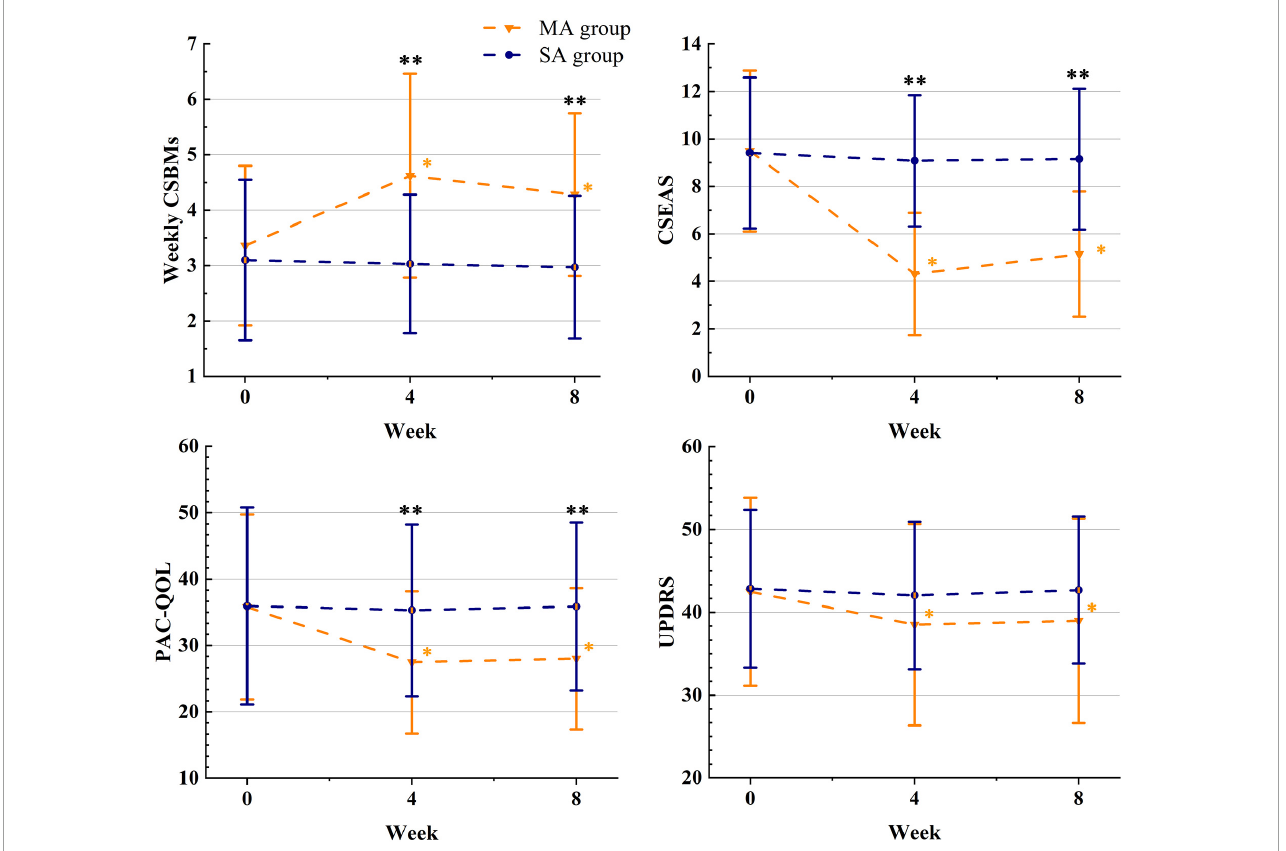
FIGURE2 The therapeutic effects of acupuncture. ∗ The difference with the baseline was significant within group ( P ≤ 0.05); ∗∗ the difference between the groups was significant ( P ≤ 0.05); MA, manual acupuncture; SA, sham acupuncture; Weekly CSBMs, weekly complete spontaneous bowel movements; CSEAS, Constipation Symptom and Efficacy Assessment Scale; PAC-QOL, Patient-Assessment of Constipation Quality of Life questionnaire; UPDRS, Unified Parkinson’s Disease Rating Scale.